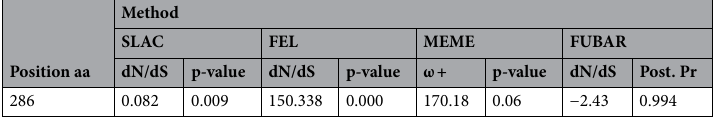
Table 1. Echovirus 9 VP1 negative selection site.